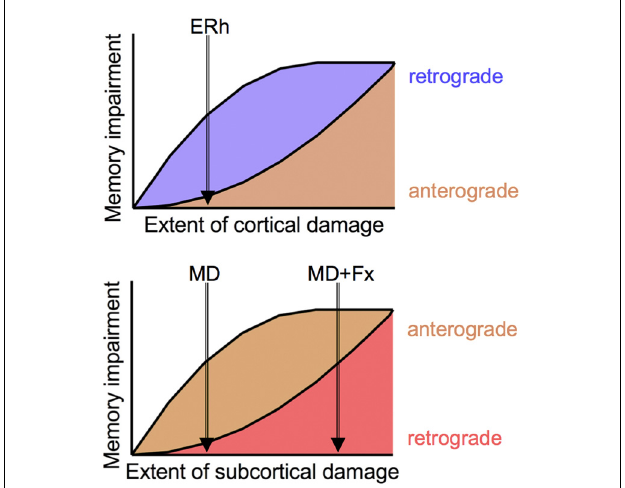
FIGURE 1 | Conceptual model of relationship between cortical and subcortical damage and degree of retrograde and anterograde amnesia. As degree of damage increases, so does severity of amnesia, but retrograde amnesia is more sensitive to cortical damage ( Top panel ) and anterograde amnesia is more sensitive to subcortical damage ( Bottom panel ). Small cortical lesions, as of anterior entorhinal cortex (ERh), produce retrograde amnesia but no anterograde amnesia; small subcortical lesions, as neurotoxic lesions of medial MD (MD), produce anterograde amnesia but no retrograde amnesia. More extensive subcortical lesions, as of MD and fornix (MD + Fx) produce both anterograde and retrograde